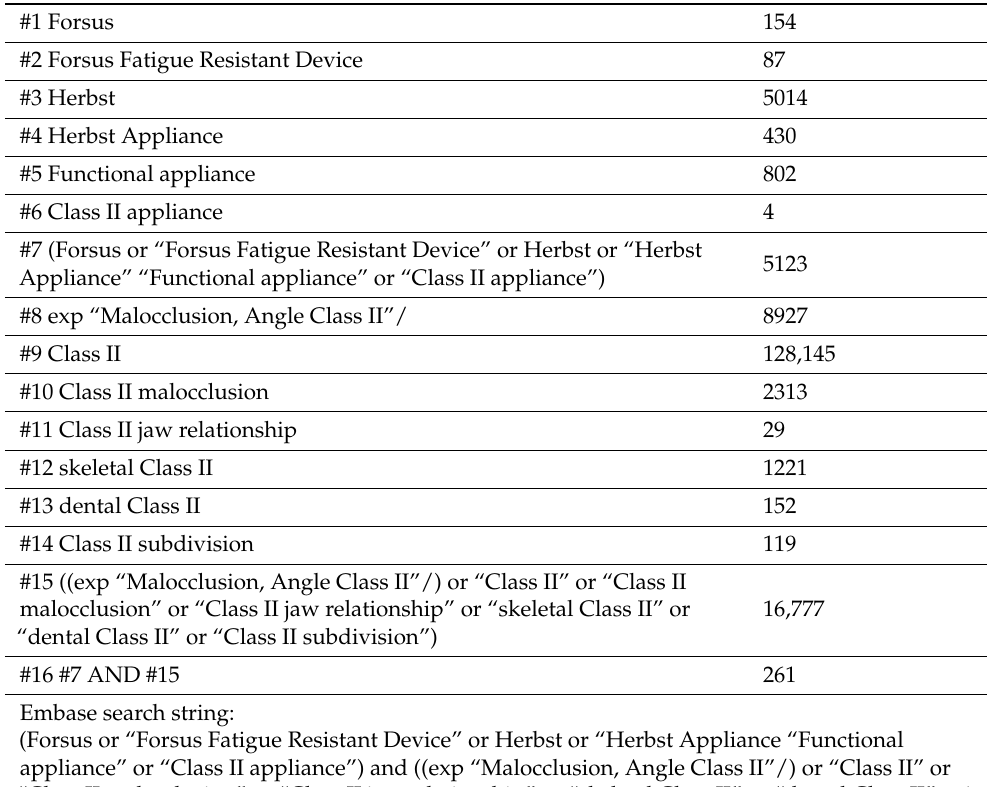
Table A3. Search strategy and search string for